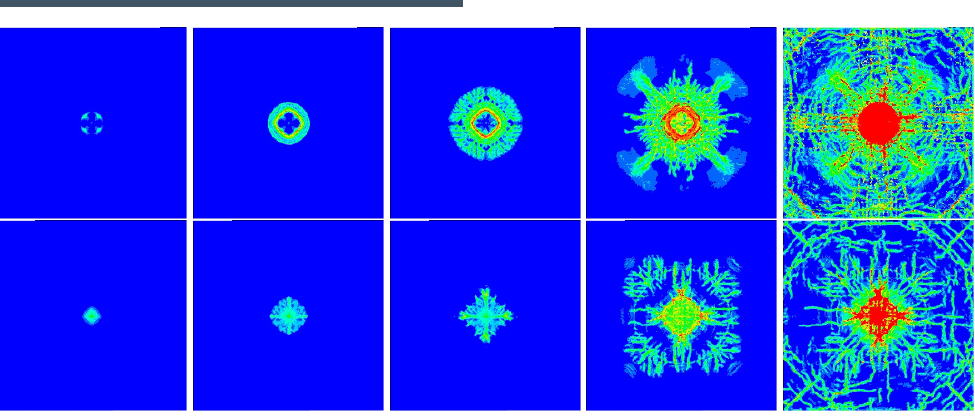
Figure 6. The time-evolution of the damage map for the top face (top row) and bottom face (bottom row) of the second layer. From left to right, snapshots taken at 12, 18, 24, 43, and 127 µ s from the contact between the projectile and the glass laminate. See movie 3 for the top